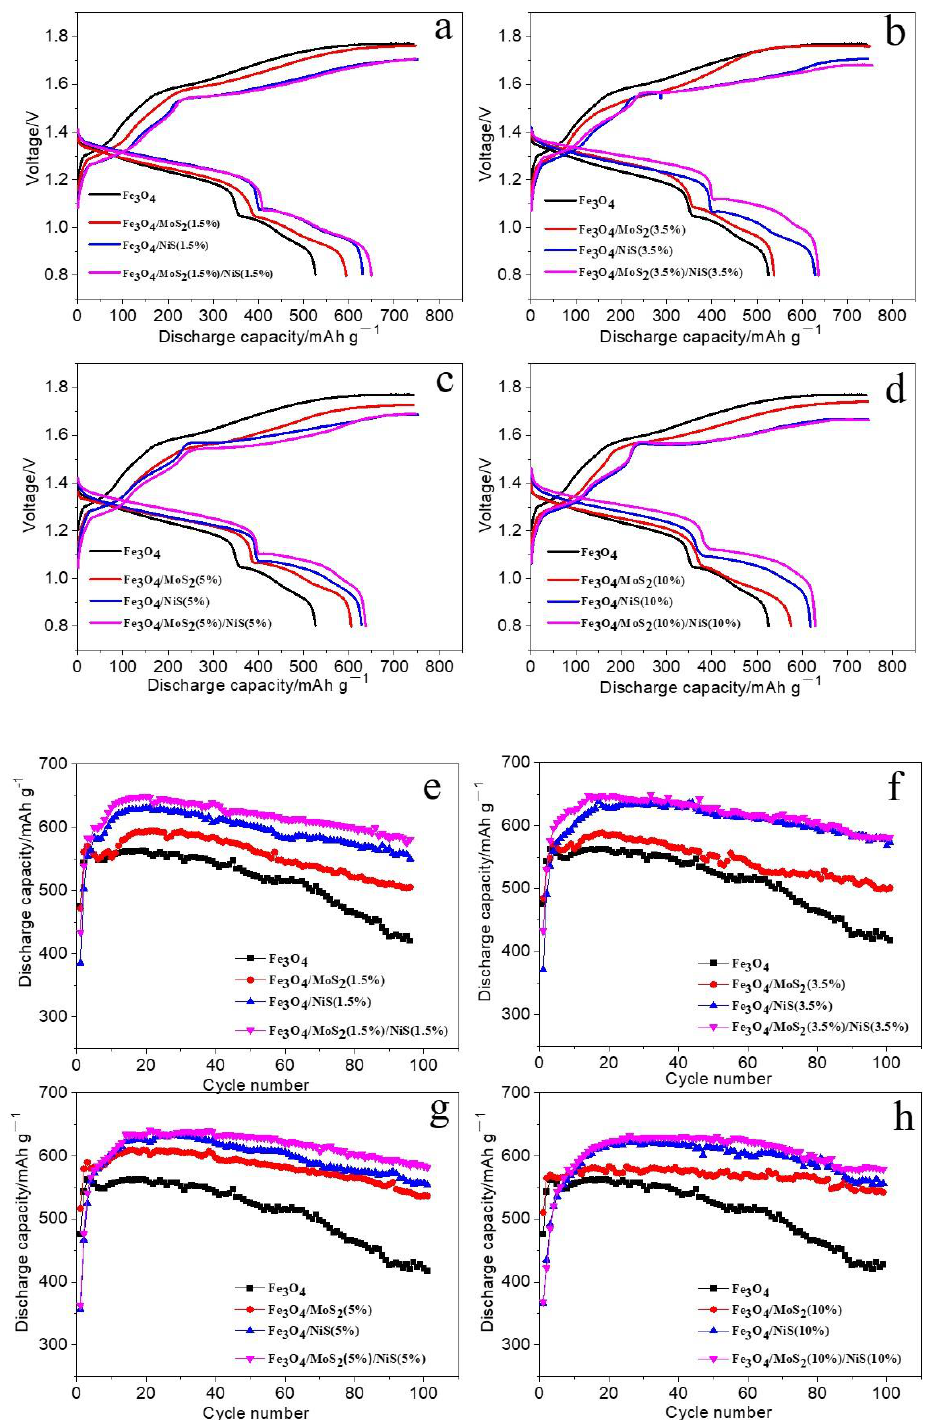
Figure 4. Charge-discharge curves and cycle capacity plots of, Fe 3 O 4 , Fe 3 O 4 /MoS 2 , Fe 3 O 4 /NiS and Fe 3 O 4 /MoS 2 /NiS electrodes at the current density of 300mA/g, when the additive content is 1.5% ( a,e ), 3.5% ( b,f ), 5% ( c,g ) and 10% ( d,h ) respectively. The XRD and XPS results of Fe 3 O 4 /MoS 2 /NiS after cycling are provided in the Sup- plementary Materials (Figures S2 and S3). Compared with the primary Fe 3 O 4 /MoS 2 /NiS (5%), the XRD peaks of the electrode after 100 cycles correspond to nickel foam and MoS 2 , respectively. No other new peaks are found, indicating that the crystal structure is stable